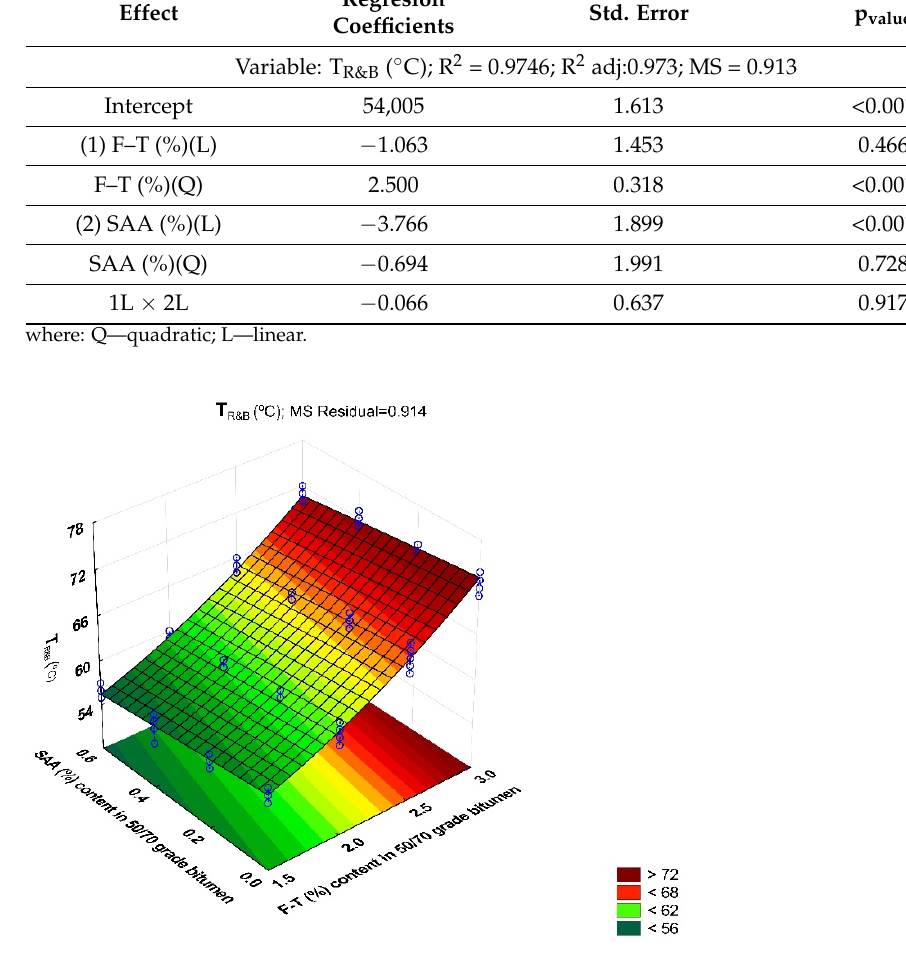
Table 5. Evaluation of the significance (ANOVA) of the factorial impact (F–T wax and SAA) on T R&B.